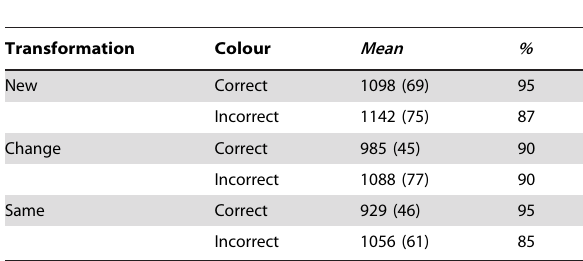
Table 1. Mean response times (msec) and percentage correct (%) for the coloured-object decision test; values in brackets represent standard